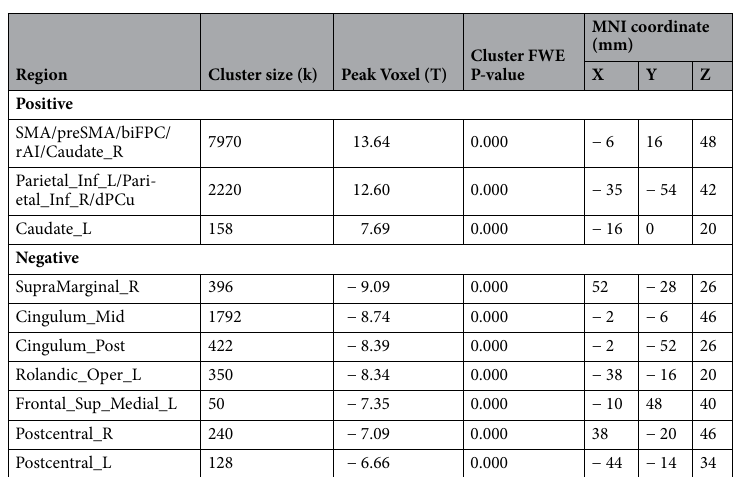
Table 2. Clusters showing correlation with RT 2–0 (correct trials only), with age, sex, years of education as covariates. R right, L left, SMA Supplementary Motor Area, biFPC bilateral frontoparietal cortex, rAI right anterior insula, dPCu dorsal precuneus